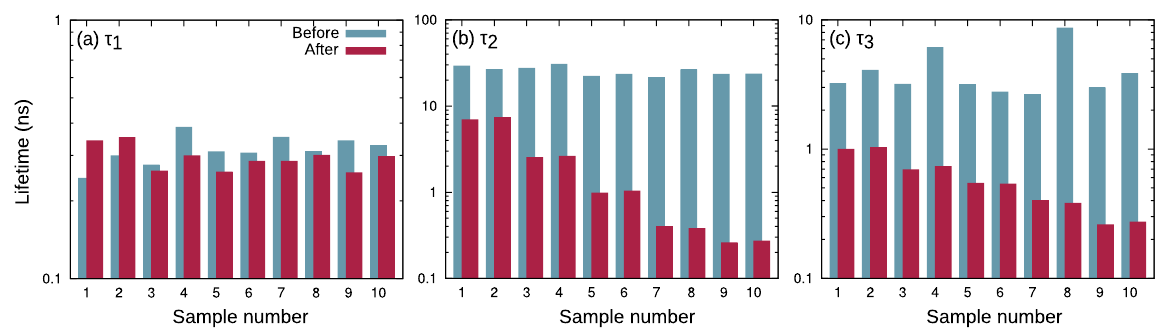
Figure 6. GaAs subcell PL decay time constants: ( a ) τ 1 , ( b ) τ 2 , and ( c ) τ 3 . Blue and red bars represent values before and after electron irradiation, respectively.